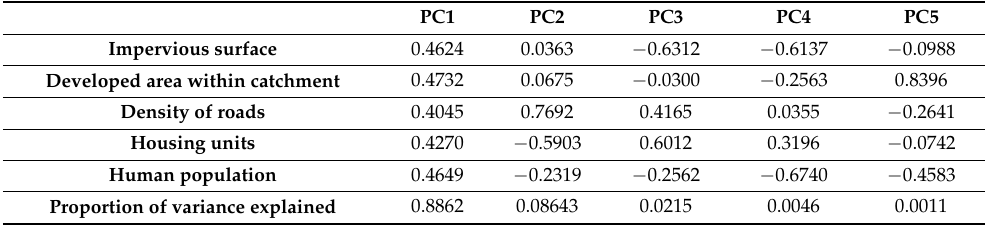
Table 2. Loadings and proportion of variance explained on different principal component (PC) axes from a principal components analysis.